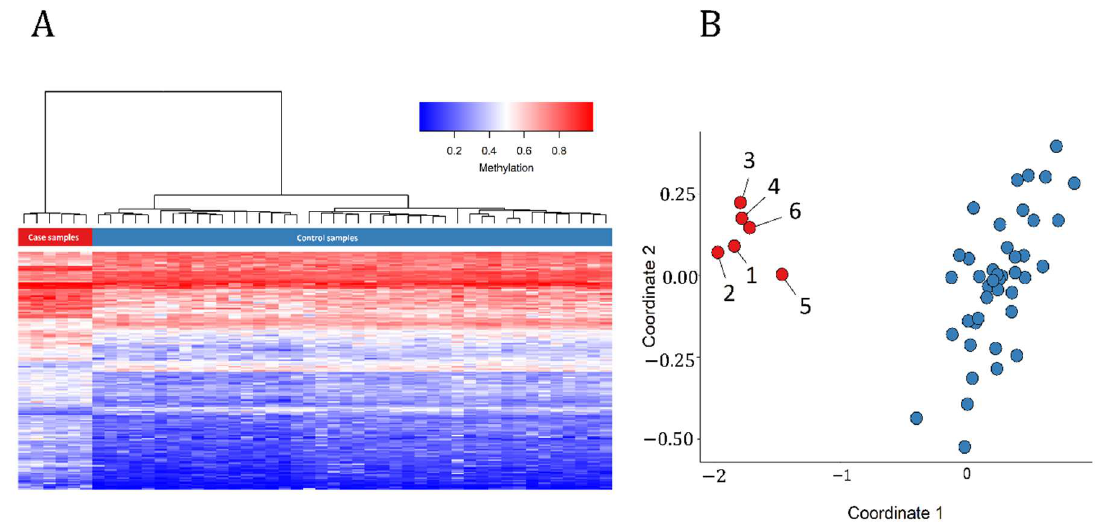
Figure 1. Assessment of the strength of the identified episignature in distinguishing intellectual developmental disorder, X-linked, syndromic, Armfield type (MRXSA) case subjects from controls. ( A ) Hierarchical clustering with Ward’s method on Euclidean distance was performed. In the heatmap, each row illustrates a selected CpG site, and each column is related to a sample. The heatmap pane represents the phenotype. The heatmap color scale indicates the range of methylation level; from blue (no methylation or 0) to red (full methylation or 1). This plot conveys that the detected episignature clearly differentiates between case and control subjects. ( B ) Multidimensional scaling plot using the selected probes, illustrating the power of the signature in separating the case and control groups. Blue circles represent healthy control subjects and red circles indicate subjects with a confirmed diagnosis of the